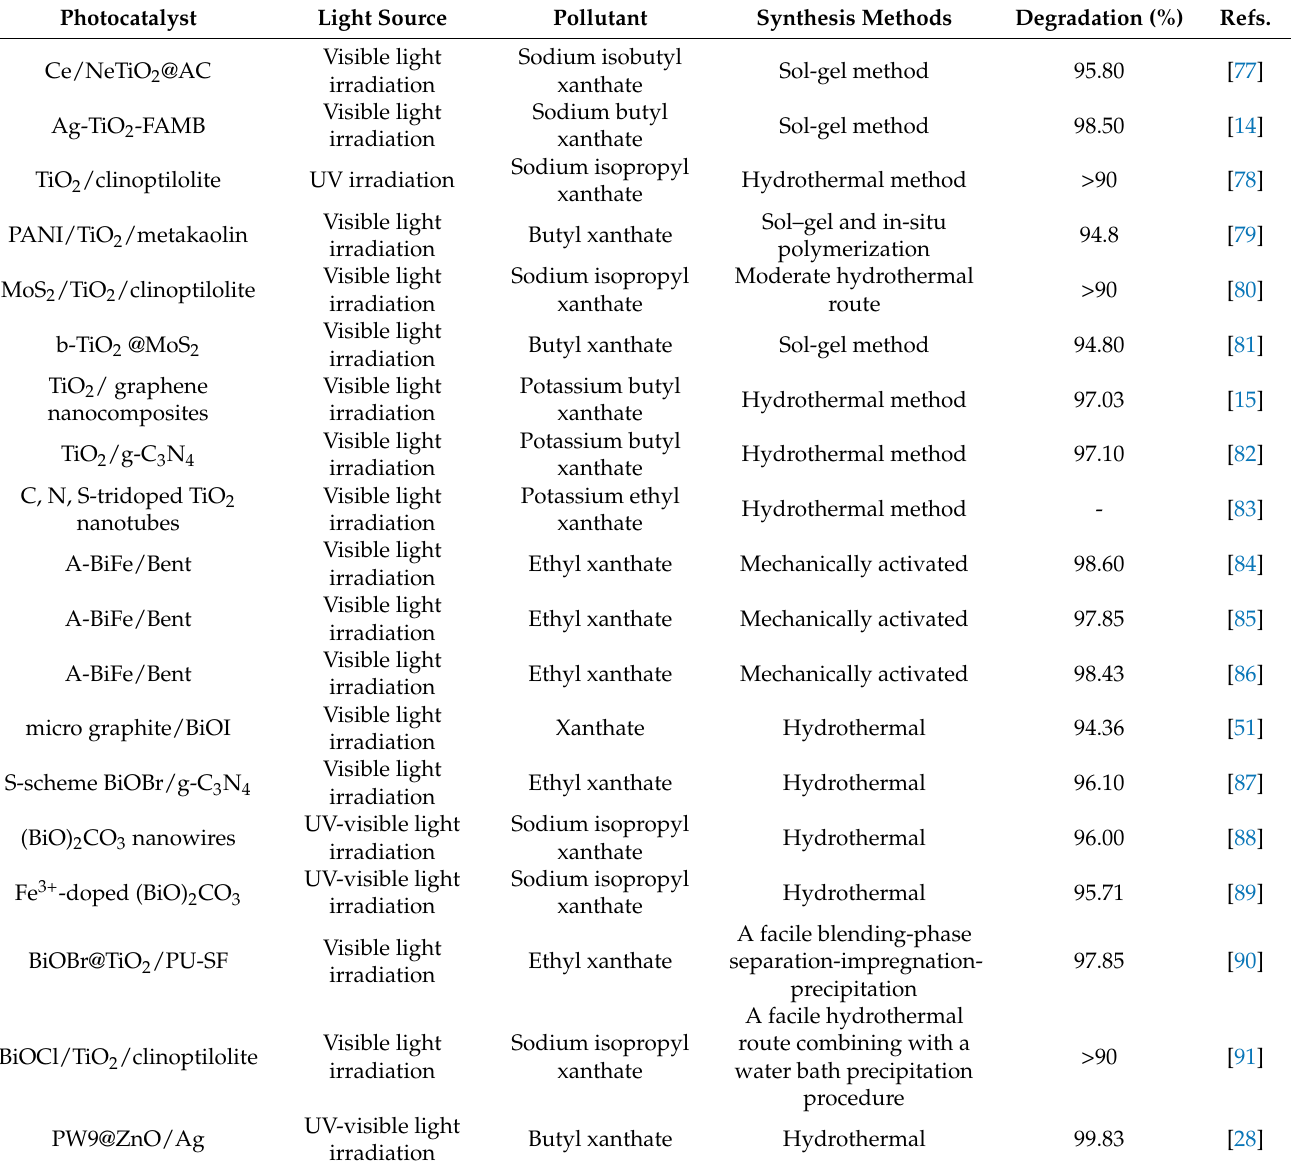
Table 2. The degradation efficiency of different modified catalysts for